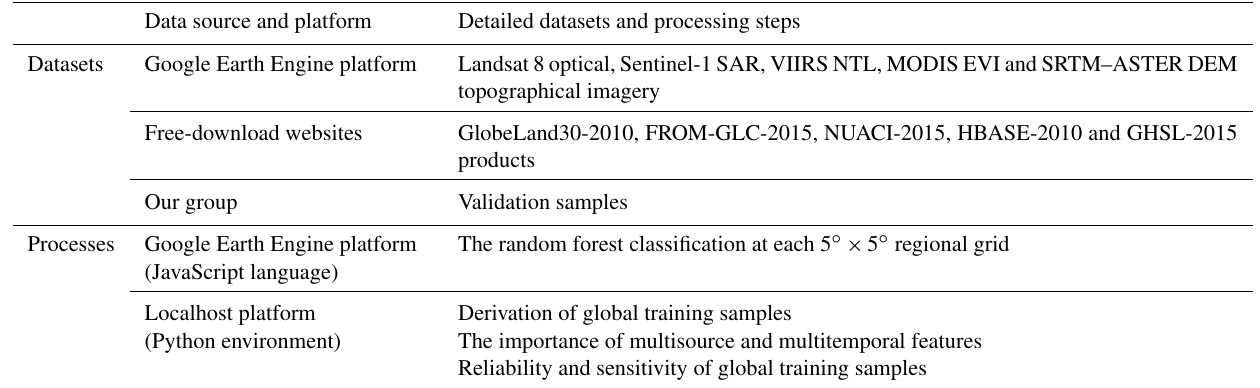
Table 3. The detailed information of the datasets and processes in this study. Data source and